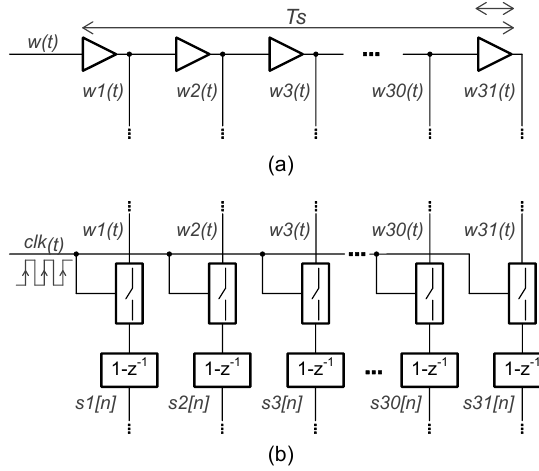
Figure 4. Time-to-digital converter: ( a ) 31-stage delay line; ( b ) sampling and demodulation